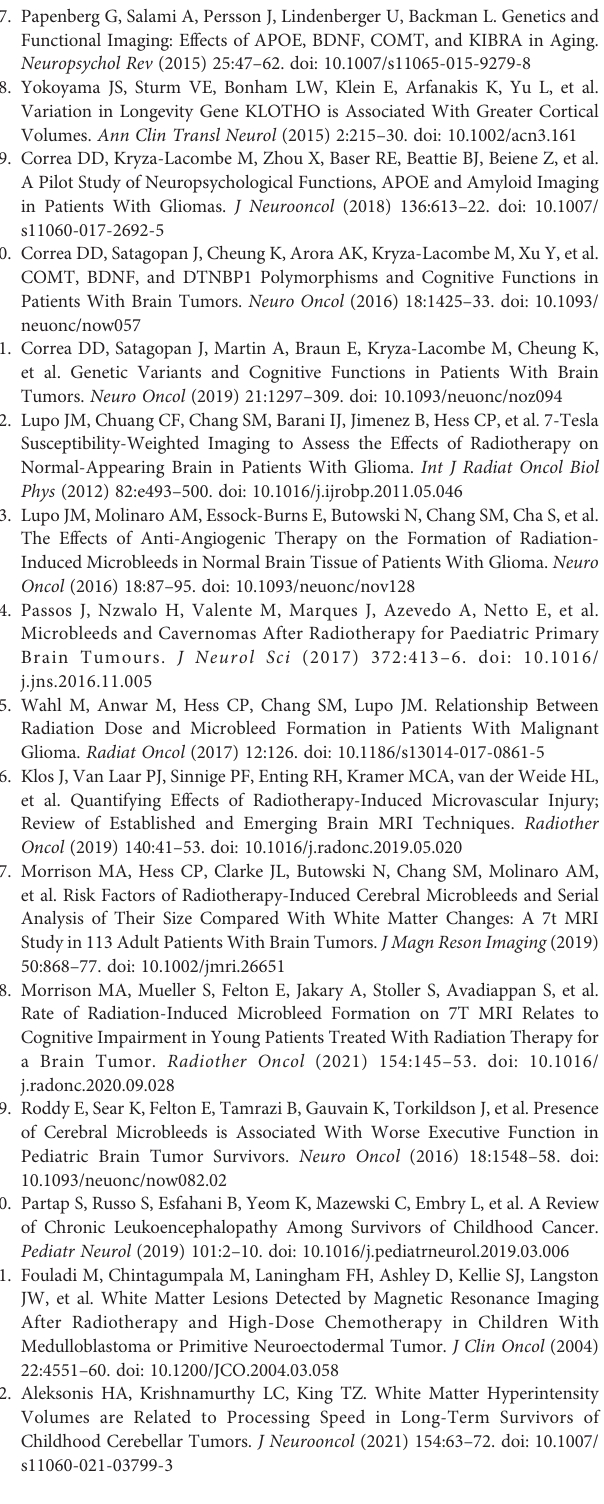
Supplementary Table 1 | Description of candidate gene SNPs of interest and anticipated impact on neurocognitive outcome. Candidate gene alleles sequenced and expected effects on neurocognitive outcomes